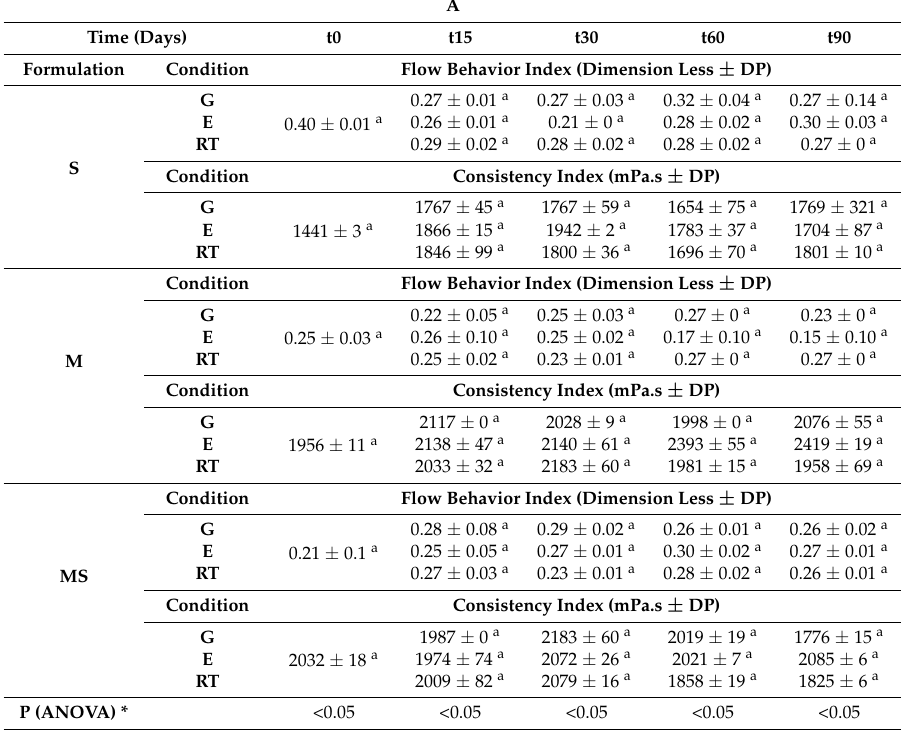
Figure 1. ( A ) Upward and downward flow curves representing hysteresis areas for formulations S (rutin succinate), M (chemical and physical filters) and MS (rutin succinate + chemical and physical filters) obtained 24 h after formulation samples were prepared (t 0 ). ( B ) Apparent viscosity curves versus time for formulations S (rutin succinate), M (chemical and physical filters) and MS (rutin succinate + chemical and physical filters). Variations of apparent viscosity with time refer to data obtained at a shear rate of 200 s − 1 . Table 6. Results for flow behavior index value ( n ) and consistency index (K) of photoprotective formulations developed with cream base A with the addition of chemicals and physical filters ( M ), rutin succinate ( S ) and rutin succinate + chemical and physical filters ( MS ) during Normal Stability Test.